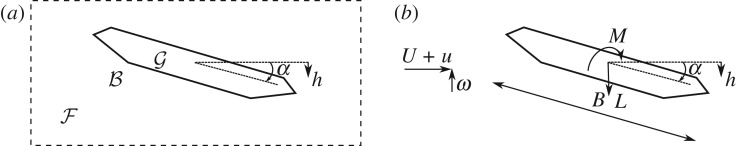
Coupled fluid–structure system for the CFD model (a); simplified system for the semi-analytical models (b).